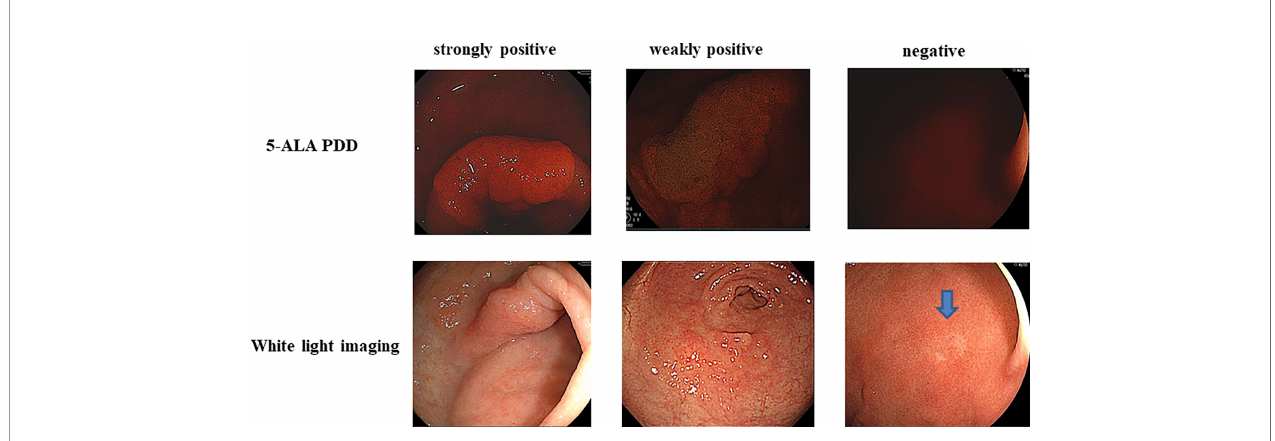
FIGURE 2 | Strongly positive (++) 5-aminolevulinic acid-mediated photodynamic diagnosis (5-ALA PDD) and weakly PDD-positive (+) and PDD-negative images are shown. The each corresponding white light imaging was shown in lower parts.